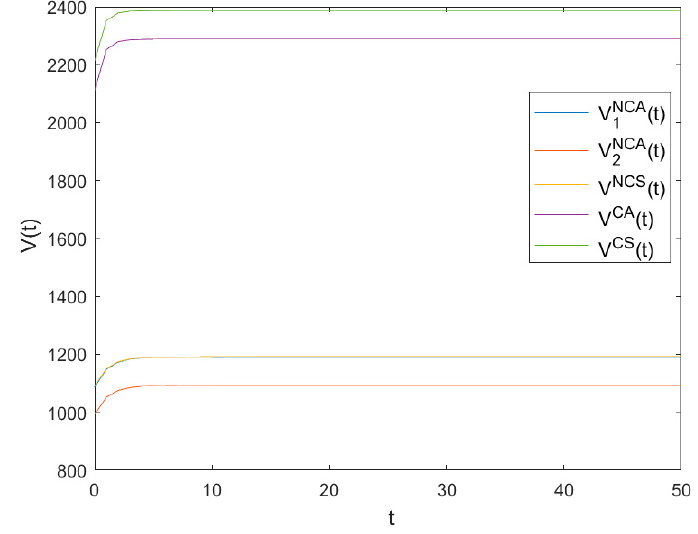
Figure 4. Evolutions of the optimal value functions.